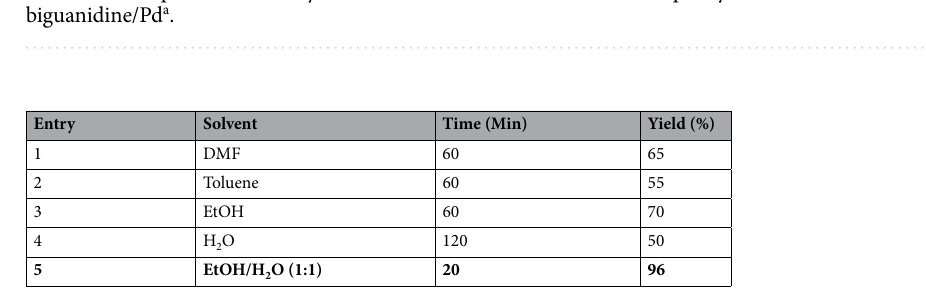
Table 3. Screening of solvent. Reaction conditions: 4-methylbromobenzene (1.0 mmol), phenylboronic acid (1.0 mmol), UiO-66-biguanidine/Pd, K 2 CO 3 as base (2 mmol) and solvent (3 mL) at 50 °C; Isolated yield.